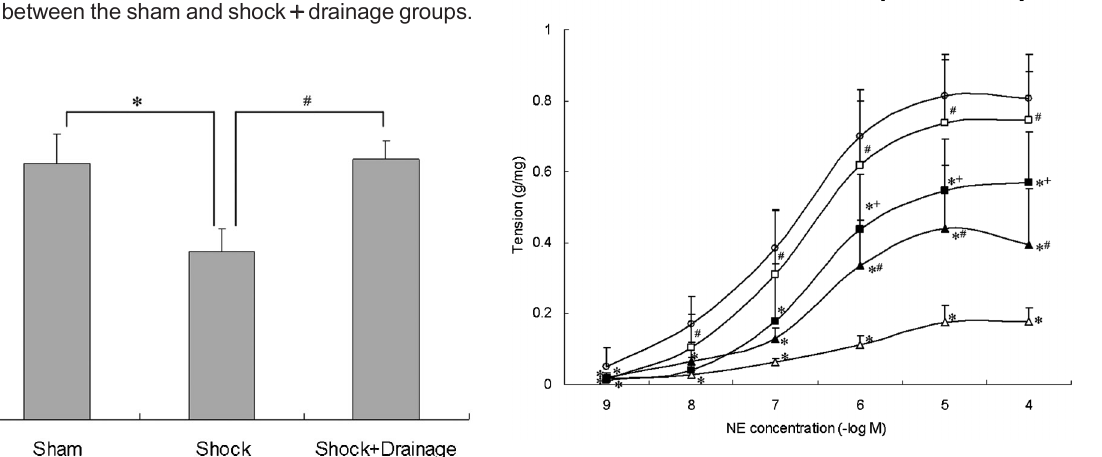
Figure 1. Effect of post-shock mesenteric lymph drainage on phospho-myosin light chain kinase (p-MLCK) level in superior mesenteric artery tissue from rats in hemorrhagic shock. Data are reported as means±SD (n=6). *P , 0.05 vs sham group, and # P , 0.05 vs shock group (one-way ANOVA).